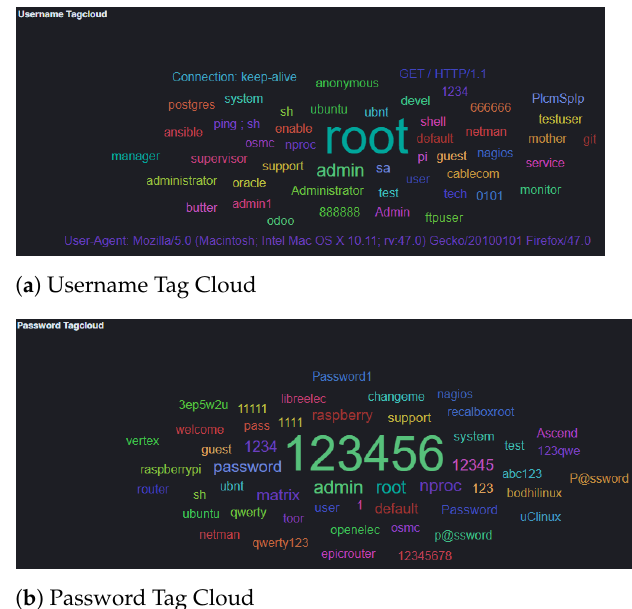
Figure 7. GCP Cowrie Username and Password Tag